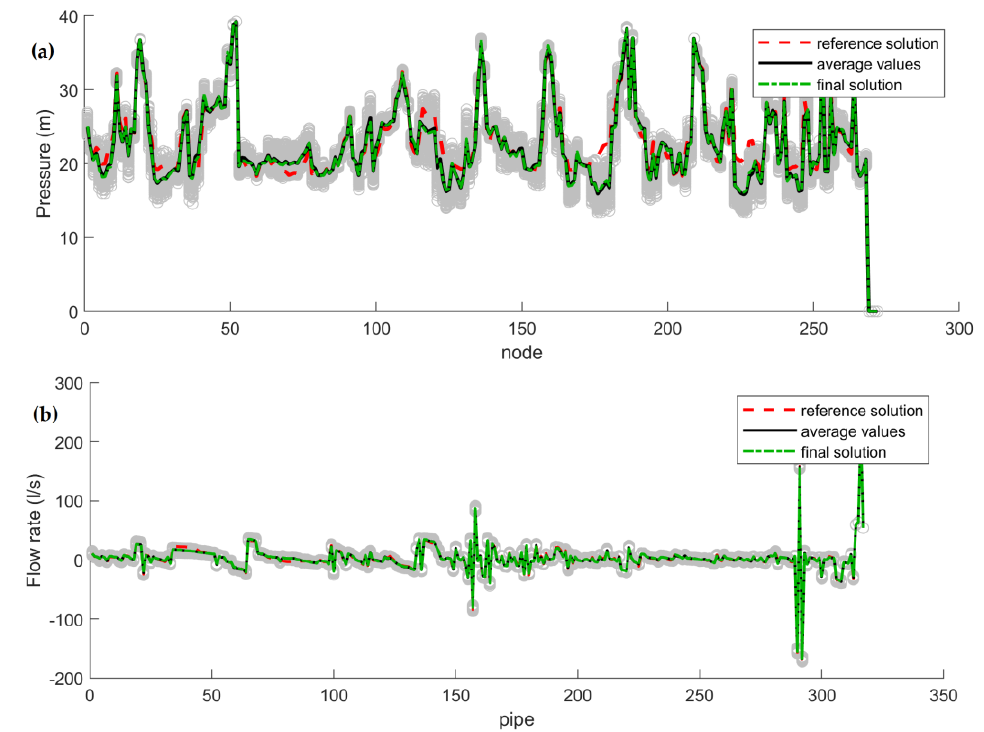
Figure 9. Resulting calibration of the Modena network with the DPD approach. In panel ( a ) is displayed the pressure distribution of the 100 runs, the reference values, the average values and the final one. The flow rate distribution of the 100 runs is displayed in panel ( b ).